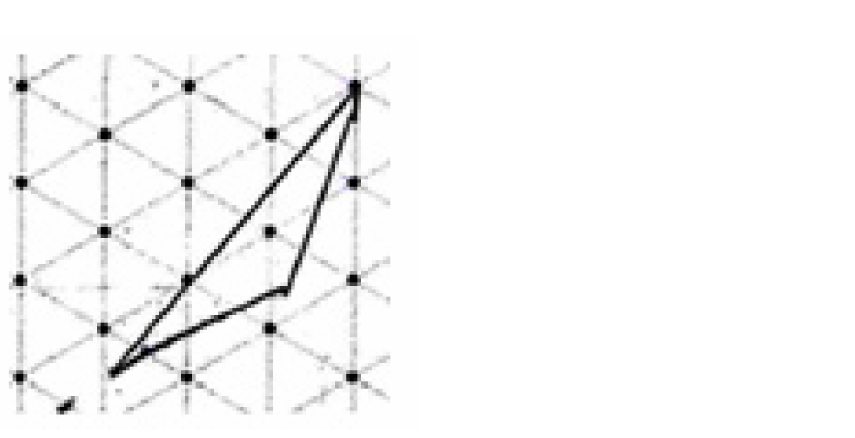
Figure 16. The answer given by student G2S27 when performing the task of drawing a polygon that fulfils certain conditions (obtuse isosceles triangle).